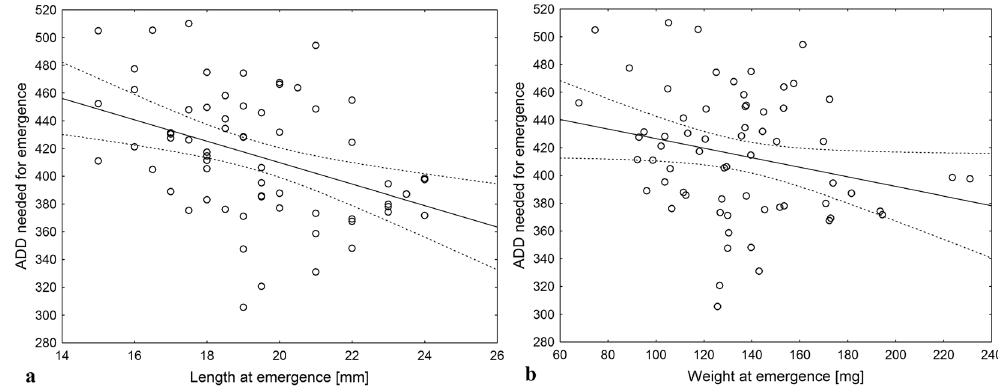
Figure 1. The relationship between adult C. maxillosus length ( a ) or weight ( b ) at emergence and thermal summation values needed for emergence (ADD over 11.58 °C). Solid line – linear regression model, dotted lines – confidence